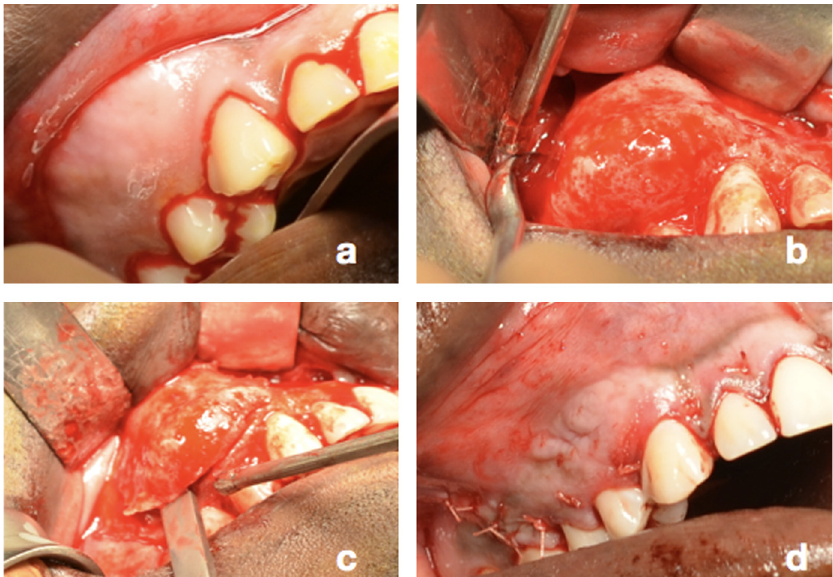
Fig. 4. Operating time during the excision of the lesion (a) vestibular incision in relation to teeth 11 – 16 with distal discharge; (b) and (c) with the aid of an osteotome and a mallet, most of the swelling was removed; (d) closure of the operative site.